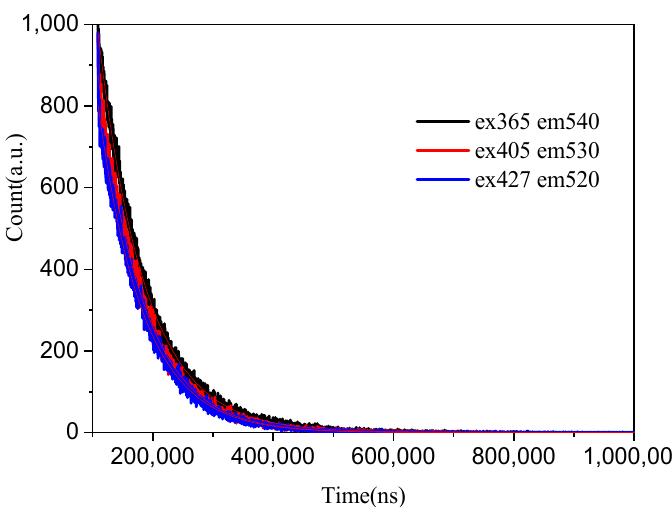
Figure 4. Lifetimes of Yb 2+ -doped silica glass monitored at 540, 530 and 520 nm when the excitation wavelength was 365, 405, and 427 nm.